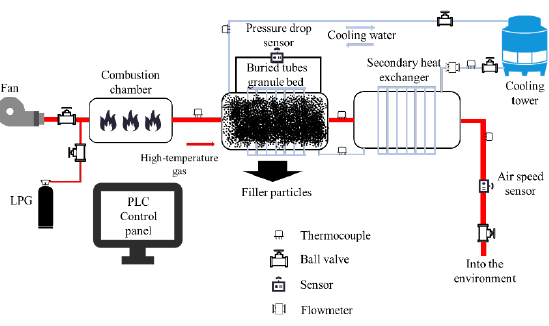
Figure 1. Schematic of the experimental flow and location of measuring points.